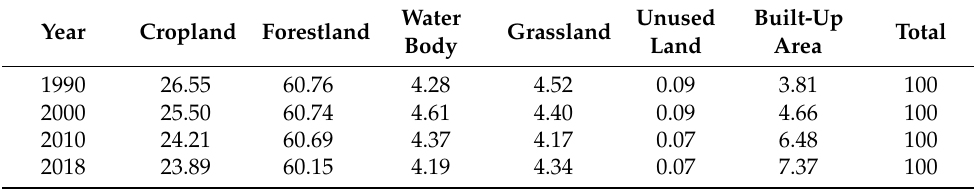
Table 4. Proportion of land-use types in Guangdong province from 1990 to 2018 (unit:%).